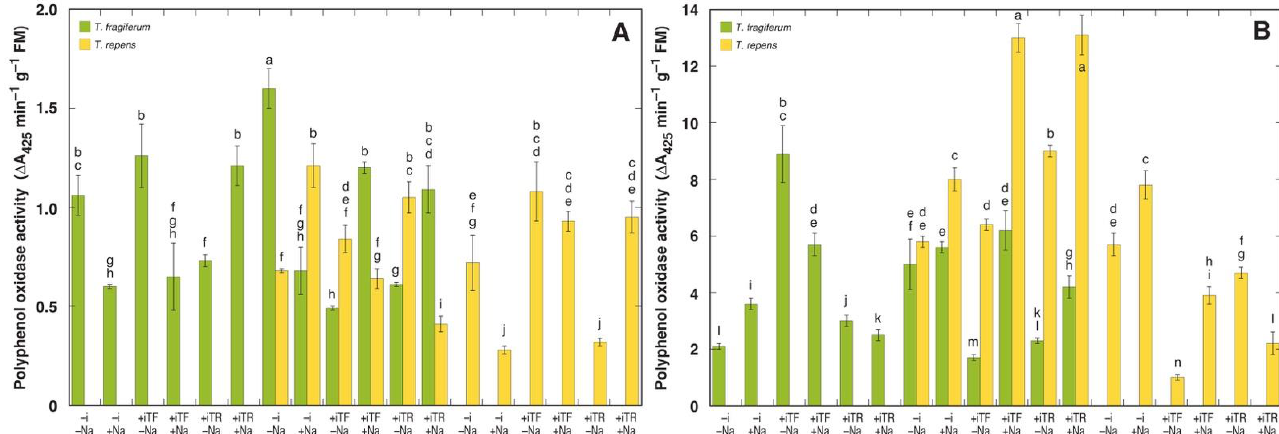
Figure 5. Peroxidase activity in leaves ( A ) and leaf petioles ( B ) of T. fragiferum and T. repens at the harvest. Data are the means from three replicates ± SE, the results are expressed on fresh mass basis. – i, without inoculant; +iTF, with inoculant isolated from T. fragiferum ; +iTR, with inoculant isolated from T. repens ; − Na, no NaCl added; +Na, NaCl up to 400 mM. Different letters indicate significant differences between the treatments ( p < 0.05).